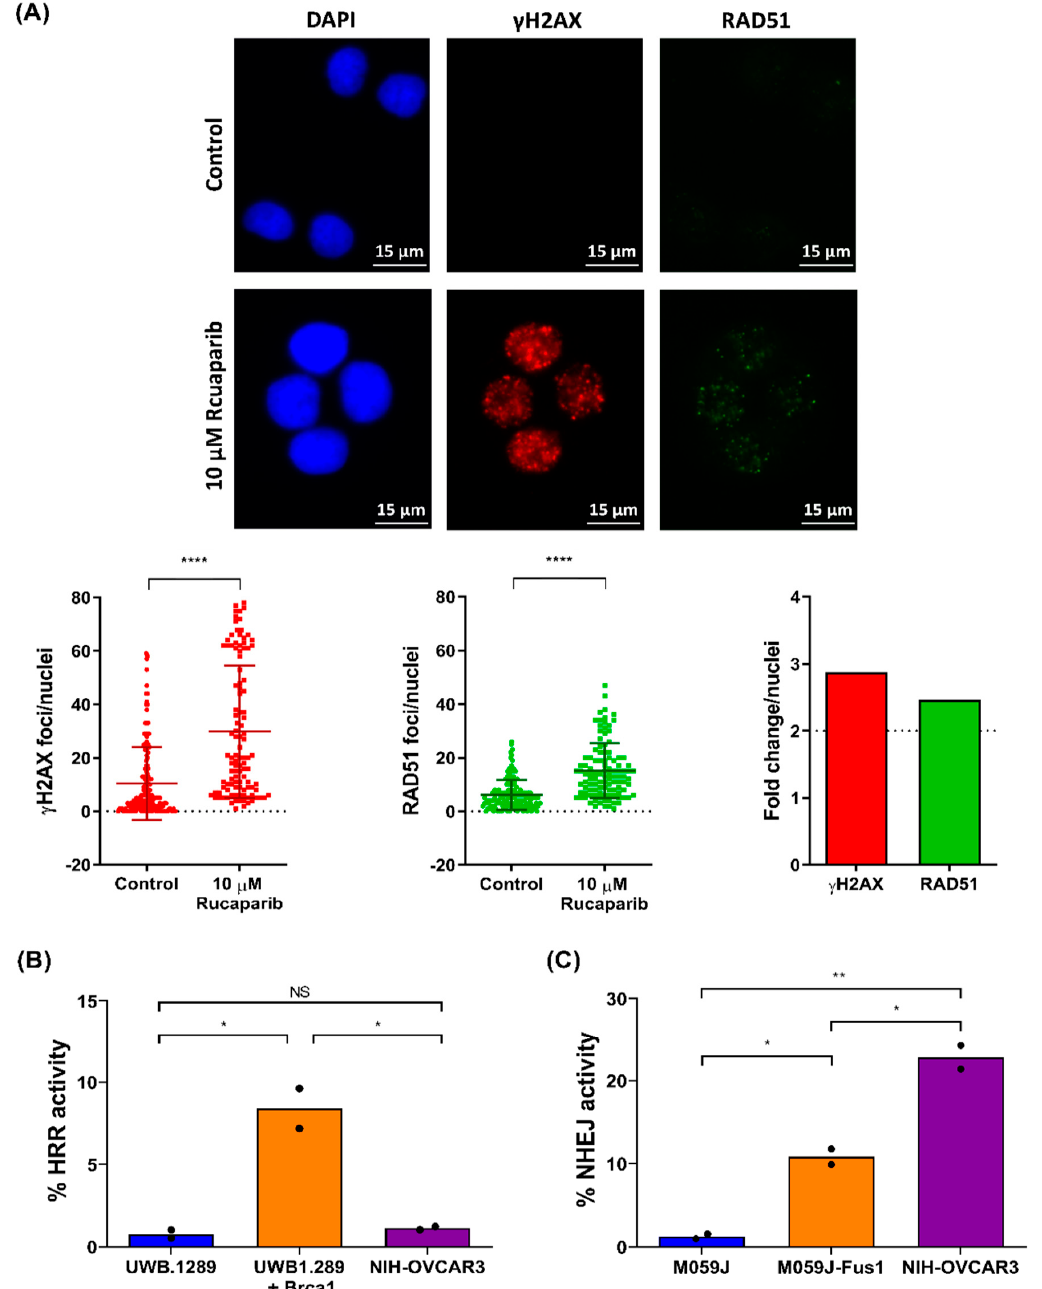
Figure 4. Assessment of HRR and NHEJ in the NIH-OVCAR3 cells. ( A ) Cells were exposed to 0.5% DMSO (control) or 10 µM rucaparib for 48 h before being fixed and stained as per the protocol outlined in the methods. After imaging, the number of γ H2AX and RAD51 foci per nucleus was calculated using ImageJ software, data points represent number of foci in an individual nucleus. The fold change in number of foci per nuclei between control and 10 µM rucaparib was then calculated. ( B ) Cells were co-transfected with pDRGFP and pCBASceI plasmids and analysed for the presence of GFP-positive cells 48 h post-transfection. % HRR activity was calculated by normalizing to the untransfected control. Graph shows mean of 2 individual experiments. ( C ) Cells were co-transfected with pimEJ5GFP and pCBASceI plasmids and analysed for the presence of GFP-positive cells 48 h post-transfection. % NHEJ activity was calculated by normalizing to the untransfected control. Graph shows mean of two individual experiments. [* p < 0.05; ** p < 0.005; **** p < 0.0001 (unpaired t